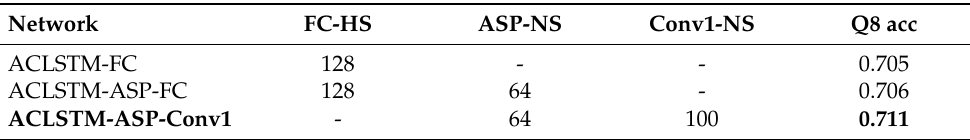
Table 4. The results of before and after inserting the ASP network into the ACLSTM network on CB513 datasets.